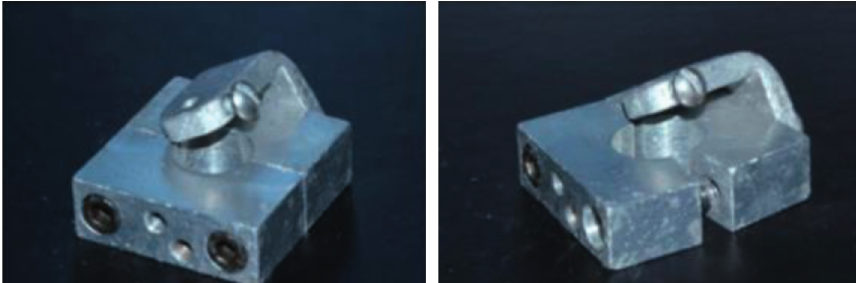
Figure 1: Bipartite metallic matrix for embedding of osseointegrated implants.